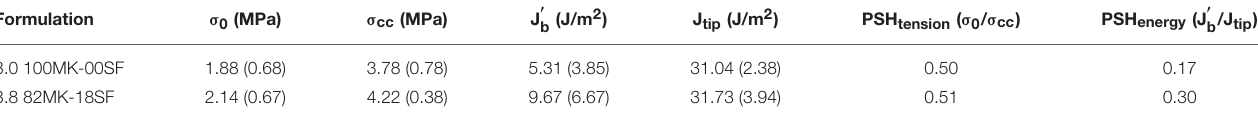
TABLE 5 | Design parameters related to the micromechanical modeling criteria. Formulation